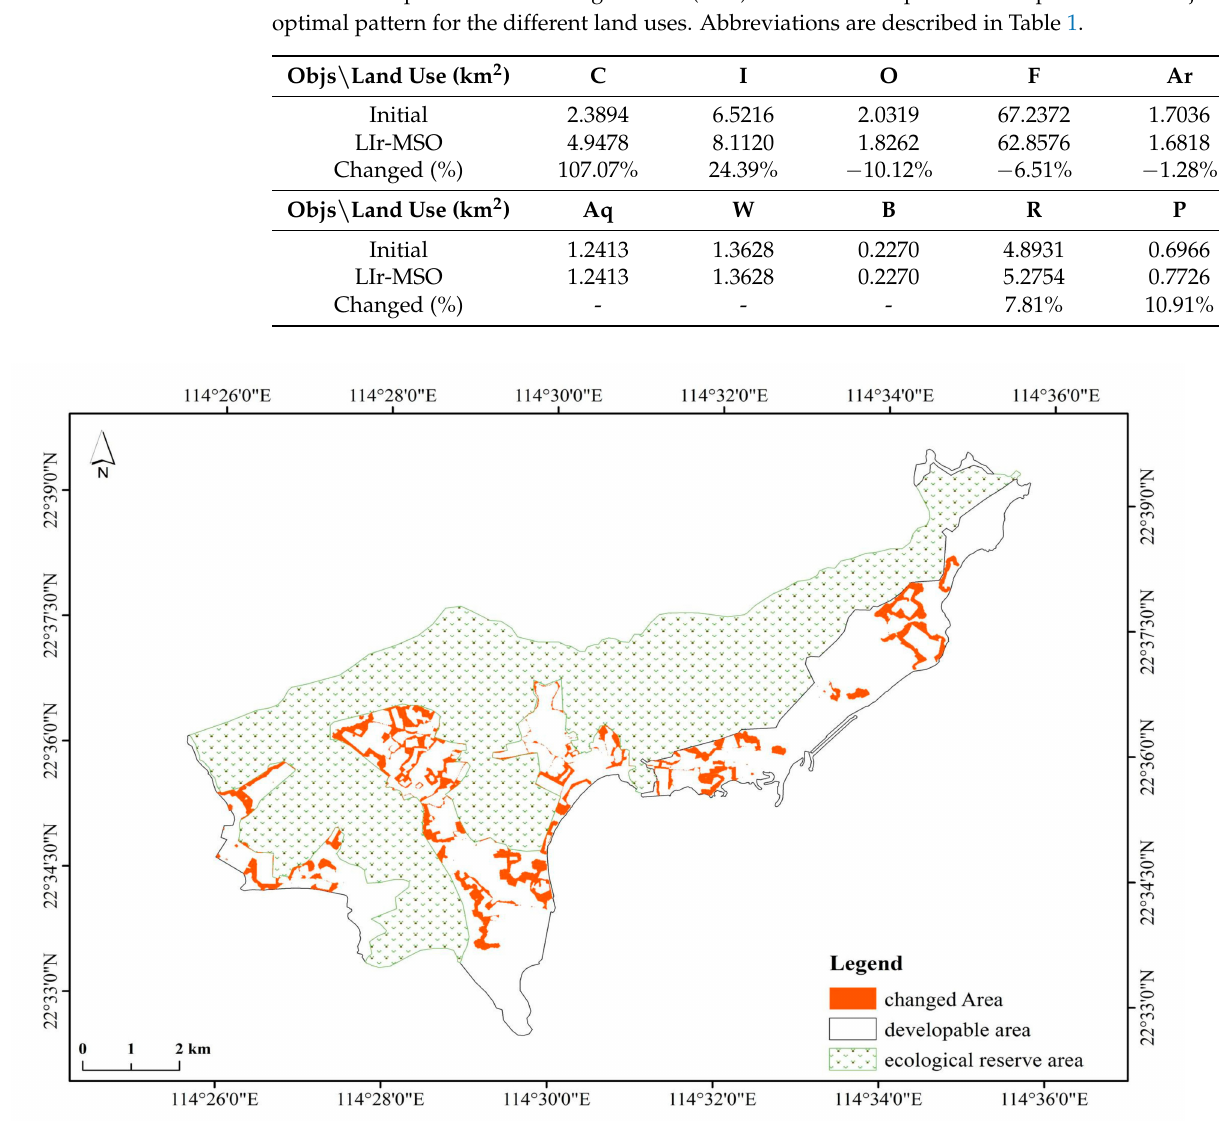
Figure 10. The pattern of areas of changed land use (regardless of type) in the developable area between the original and the optimal land-use pattern. No changed areas occur within the ecological reserve